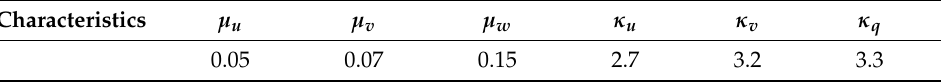
Table 2. Third and fourth-order integral turbulence characteristics recorded at 49 m above ground on MW1 (Bjørnafjord) on 8 December 2017 from from 2:00 a.m. to 5:00 a.m. For i = u , v , w , the skewness estimates are denoted µ i whereas the kurtosis estimates are named κ i